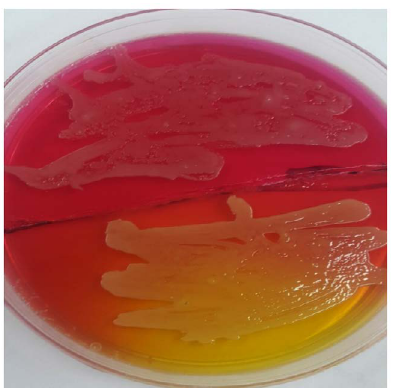
Fig. 3. Yellowish golden colonies of Staphylococcus aureus on Mannitol salt